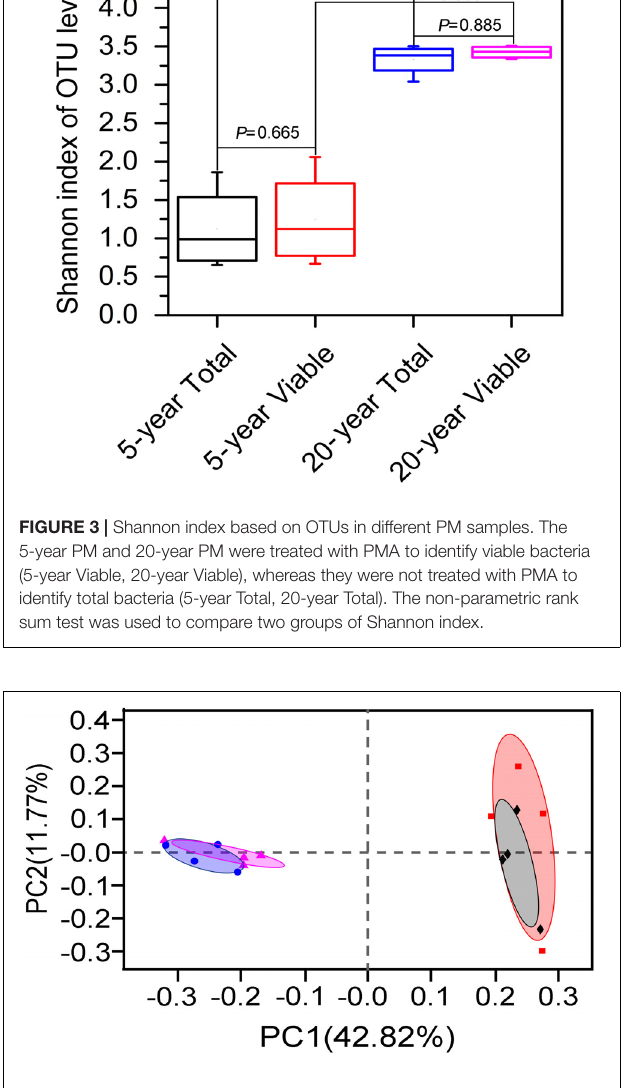
FIGURE 4 | PCoA analysis of total bacteria and viable bacteria in different PM samples ( (cid:7) ) 5-year Total, ( • ) 20-year Total, ( (cid:4) ) 5-year Viable, ( (cid:78) ) 20-year